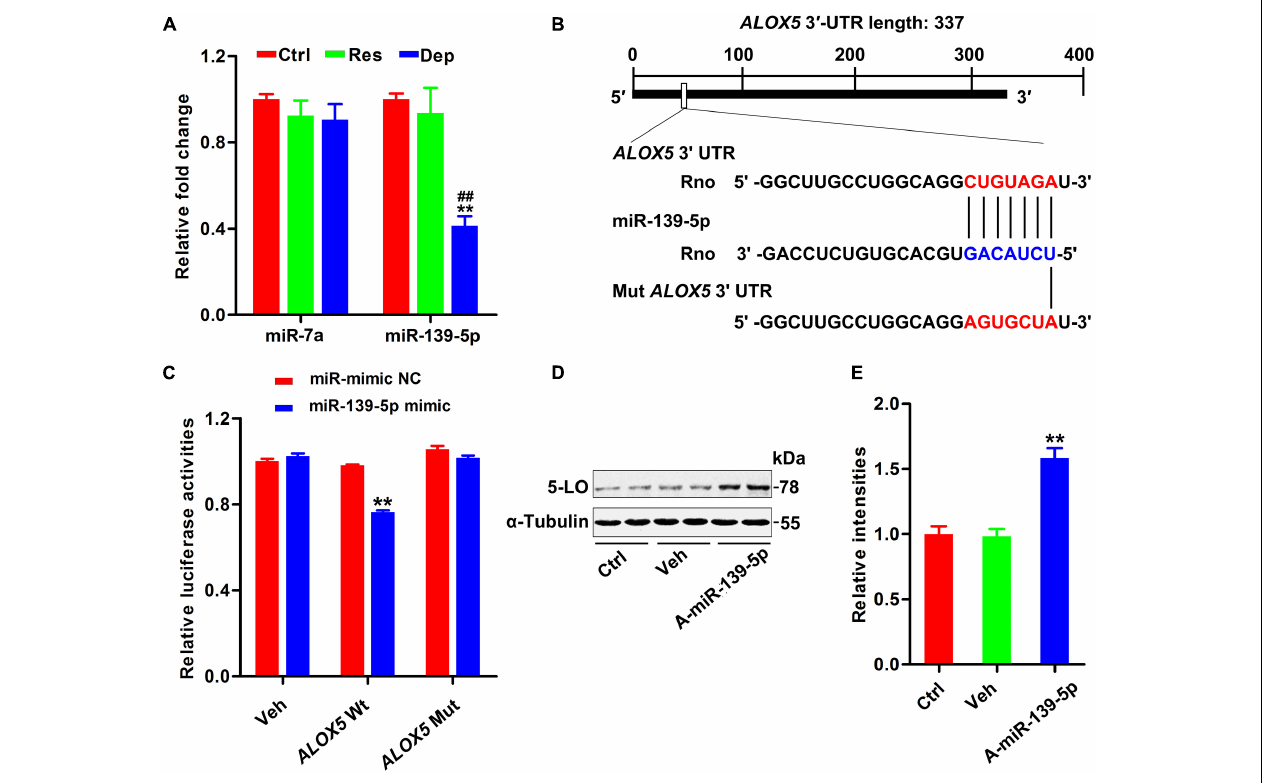
FIGURE 2 | Downregulation of miR-139-5p was responsible for 5-LO elevation. Alterations in predicted miRNAs that target 5-LO in the hippocampus of CUMS-exposed rats ( A , n = 3 brains/group) [ F ( 2 , 15 ) = 0.717 for miR-7a, p = 0.504; F ( 2 , 15 ) = 19.131 for miR-139-5p, p = 0.000]. ** p < 0.01 Res or Dep versus Ctrl. ## p < 0.01 Dep versus Res, one-way ANOVA with LSD post hoc test. The binding site for miR-139-5p seed sequence in the ALOX5 3 (cid:48) -UTR (B) . Luciferase reporter assay results demonstrated that miR-139-5p targeted ALOX5 3 (cid:48) -UTR (C) [ F ( 1 , 20 ) = 145.831 for ALOX5 wt, p = 0.000; F ( 1 , 20 ) = 1.275 for ALOX5 mut, p = 0.272]. ** p < 0.01 miR-139-5p mimic versus the negative control-treated group (miR mimic NC), two-way ANOVA and Bonferroni’s post hoc test. The 5-LO level in N2a cells treated with miR-139-5p inhibitor (A-miR-139-5p) or its scrambled control (Veh0) was tested by western blotting (D) and quantitatively analyzed (E) [ F ( 2 , 15 ) = 27.071, p = 0.000]. ** p < 0.01 A-miR-139-5p versus Veh, one-way ANOVA with LSD post hoc